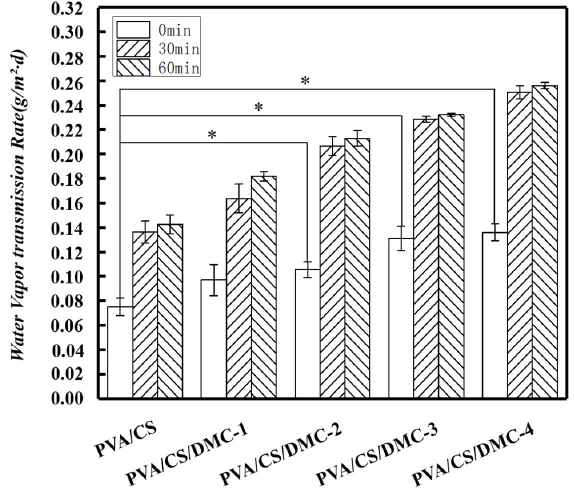
Figure 5. Water vapor rate of different composite films under different ultrasound times. a Values marking various superscripts for every parameter within the same ultrasound times differ noticeably ( p < 0.05).